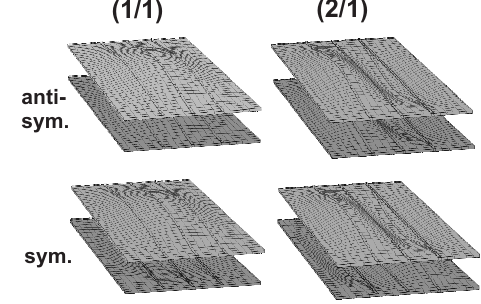
Figure 1. The symmetrical and antisymmetrical vibration of the symmetrical and antisymmetrical vibration or the two opposed membranes in the fundamental (1 / 1) mode and in the second Figure 1. The (2 / 1) mode. two opposed membranes in the fundamental (1 / 1) mode and in the second (2 / 1) mode.